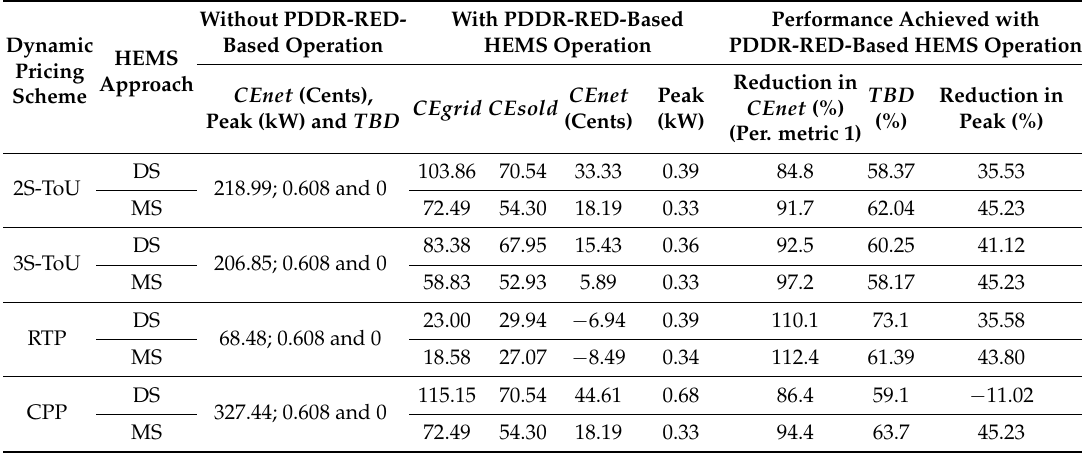
Figure 19. DWS-PSO for PDDR-RED-based HEMS: A comparative performance for maximal reduction in CEnet using weights of (1,0). Table 7. DWS-PSO for PDDR-RED-based HEMS: maximum reductions in CE , peak load and TBD for diversified TPs using weights ( CE , TBD ) =